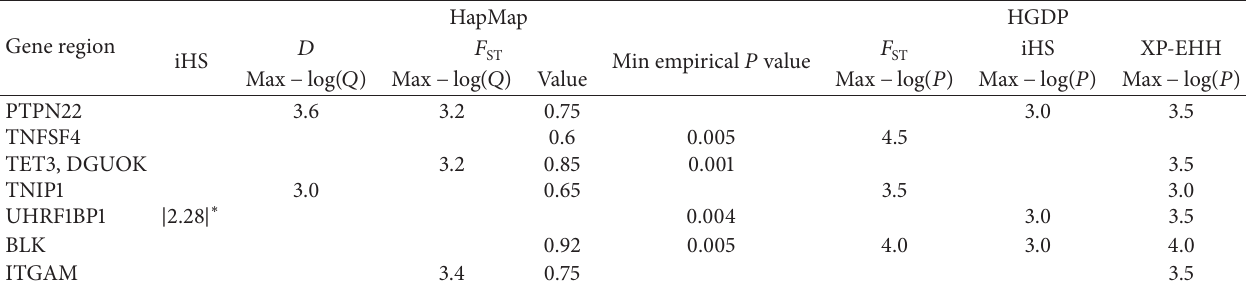
Table 4: Summary of regions with evidence for selection on both the HapMap and HGDP populations. Gene region